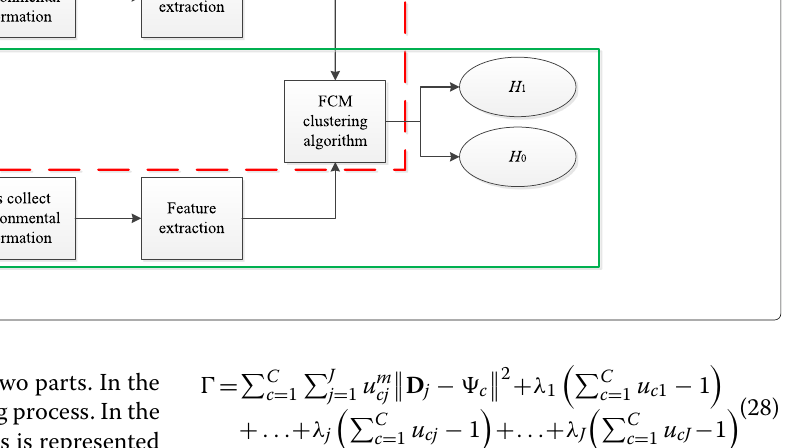
The method of IGFCM is divided into two parts. In the first part, the red box indicates the training process. In the second part, the spectrum sensing process is represented in the green